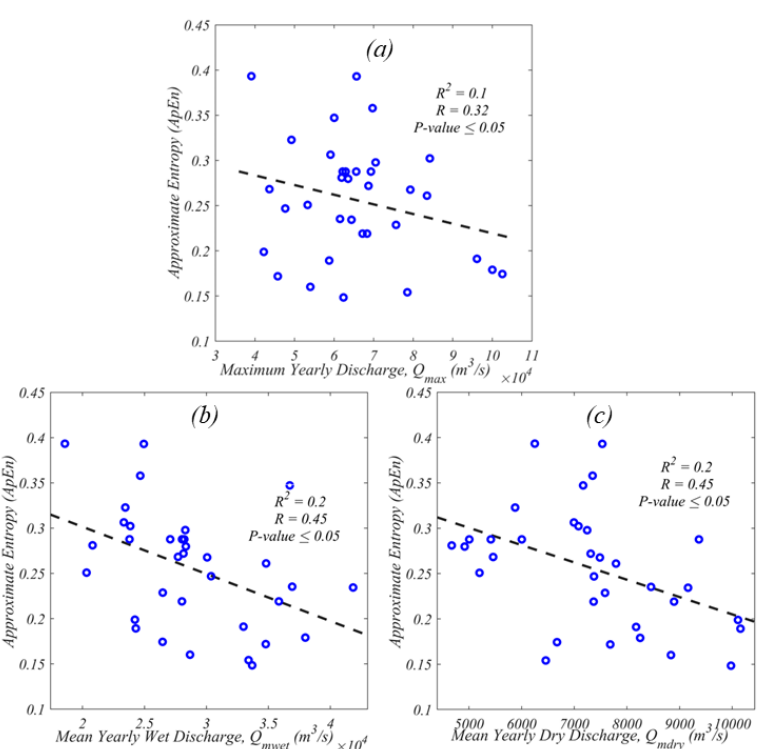
Figure 8. Correlation between Approximate entropy ( ApEn ) and ( a ) Yearly maximum discharge